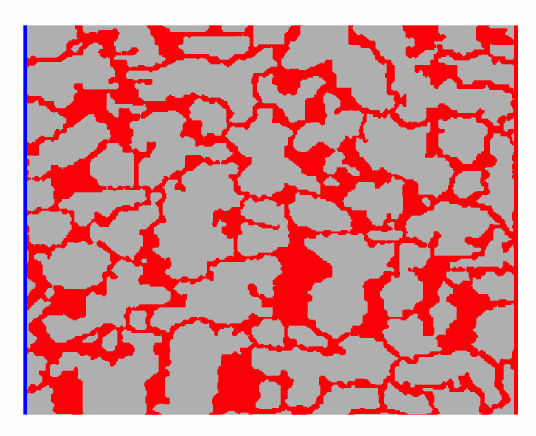
Figure 2. The 2D pore network used in the present lattice Boltzmann method (LBM) simulations. The solid grains are represented in gray, while the displacing and displaced fluids are represented in blue and red, respectively. The domain size is 1774 µ m by 1418 µ